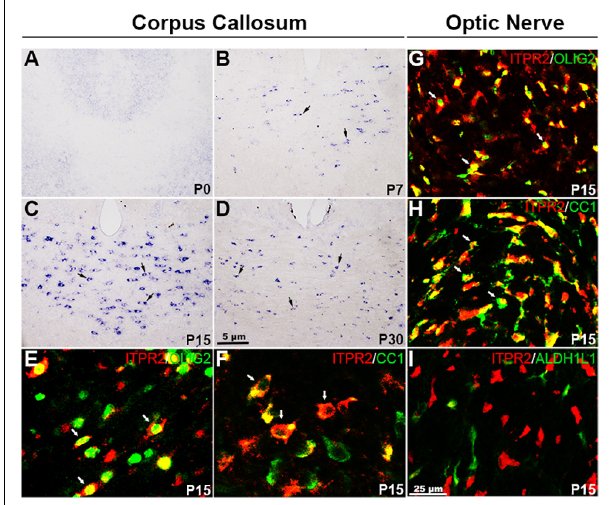
FIGURE 1 | Itpr2 is selectively up-regulated in differentiating OLs in the CNS. (A–D) Expression of Itpr2 in the forebrain tissues as detected by RNA in situ hybridization (ISH). Black arrows highlight Itpr2 + cells. The number of Itpr2 positive cells in the corpus callosum increased progressively from P7 to P15 and then decreased gradually thereafter. Scale bar represents 5 µ m. (E,F) Double immunofluorescence of anti-ITPR2 combined with anti-OLIG2 or anti-CC1 in P15 corpus callosum. Double positive cells are represented by white arrows. CC, corpus callosum; CTX, Cortex. (G–I) Representative images of ITPR2 + cells that co-express OLIG2, CC1 but not ALDH1L1 in P15 optic nerve. Scale bar represents 25 µ m.